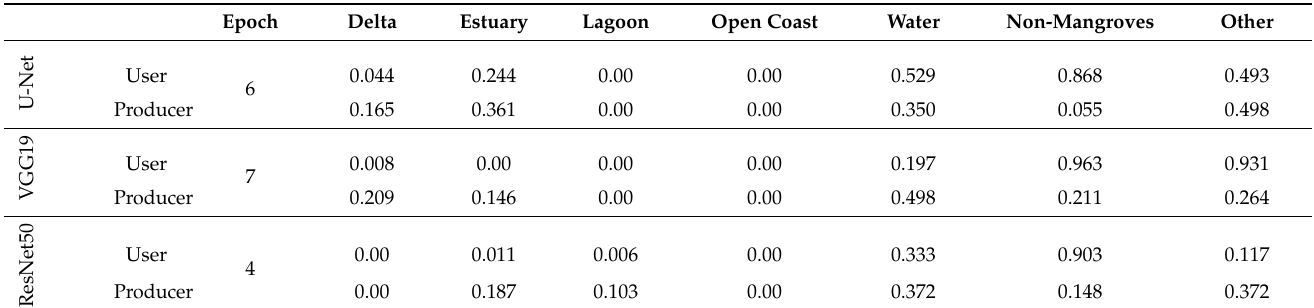
Table 5. User and producer accuracies of the deep models which scored the highest F1-score on the validation